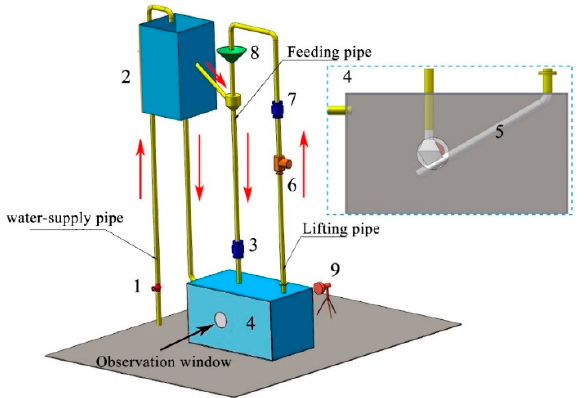
Figure 2. Schematic diagram of the experimental platform for particle transport in Y-shaped elbow (1. Water-supply valve, 2. Regulated water tank, 3 (7). Flowmeter, 4. Pressure-bearing tank, 5. Y-shaped elbow, 6. Centrifugal pump, 8. Feeding hopper and 9. Light bulb).